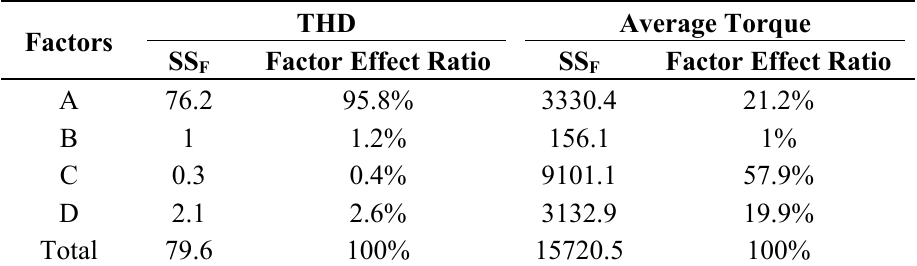
Table 12. Effects of various factors on machine performance